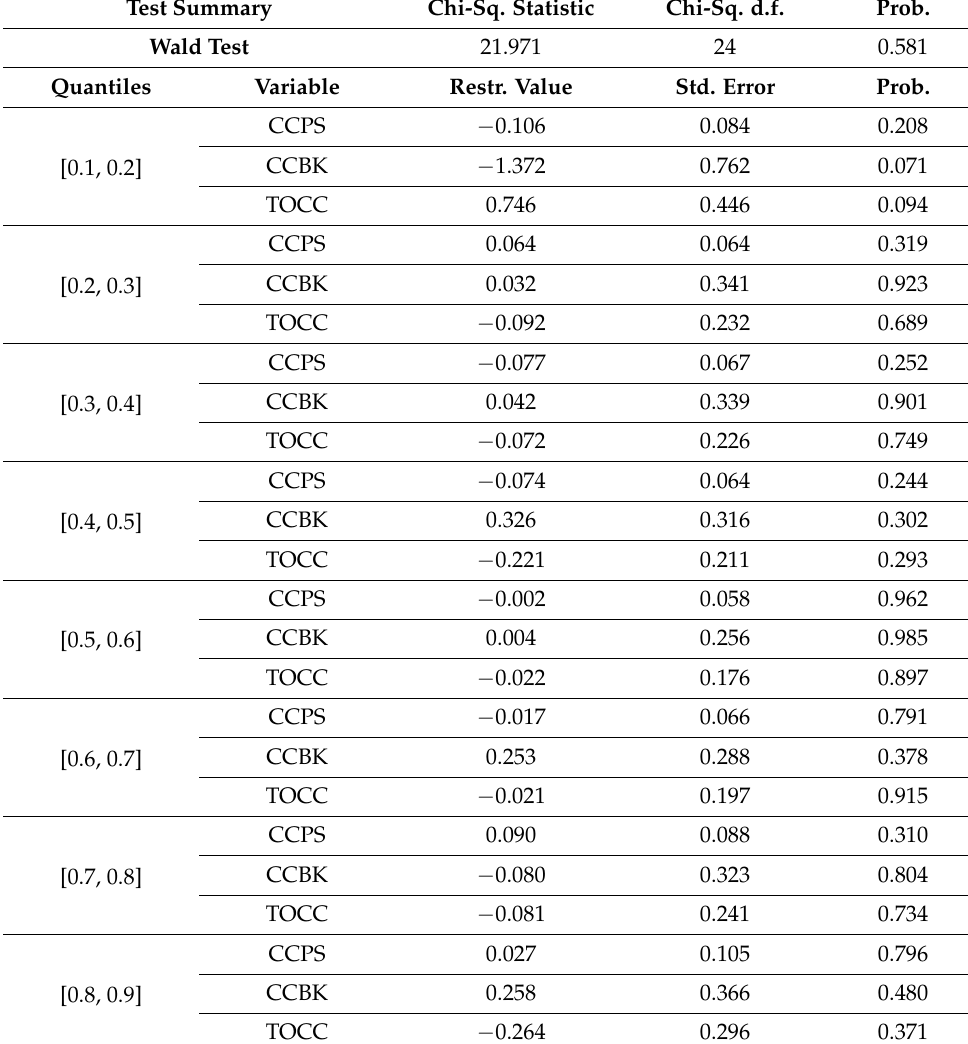
Table 7. Consequences of slope equality